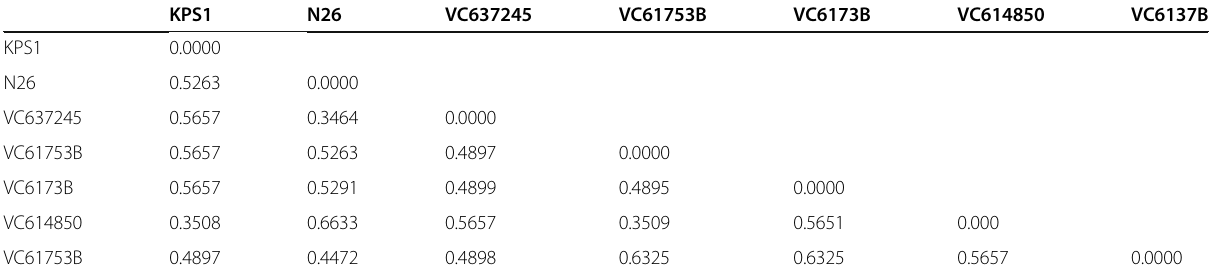
Table 6 Cord coefficients of dissimilarity among the pairs of seven green gram varieties